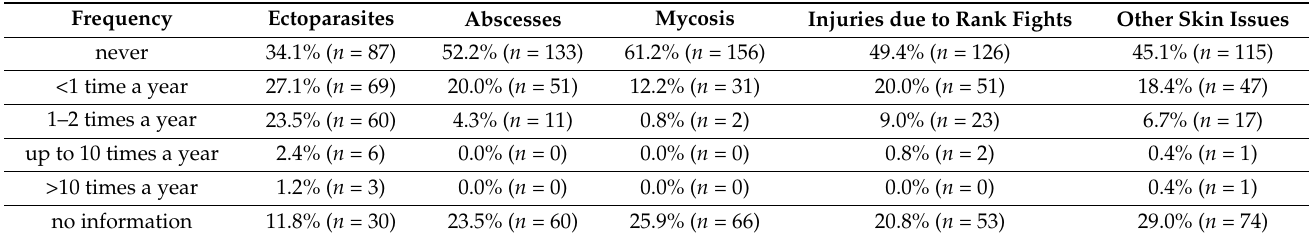
Table 7. Observation of the owners: frequency of diseases or symptoms affecting the skin ( n = 255).